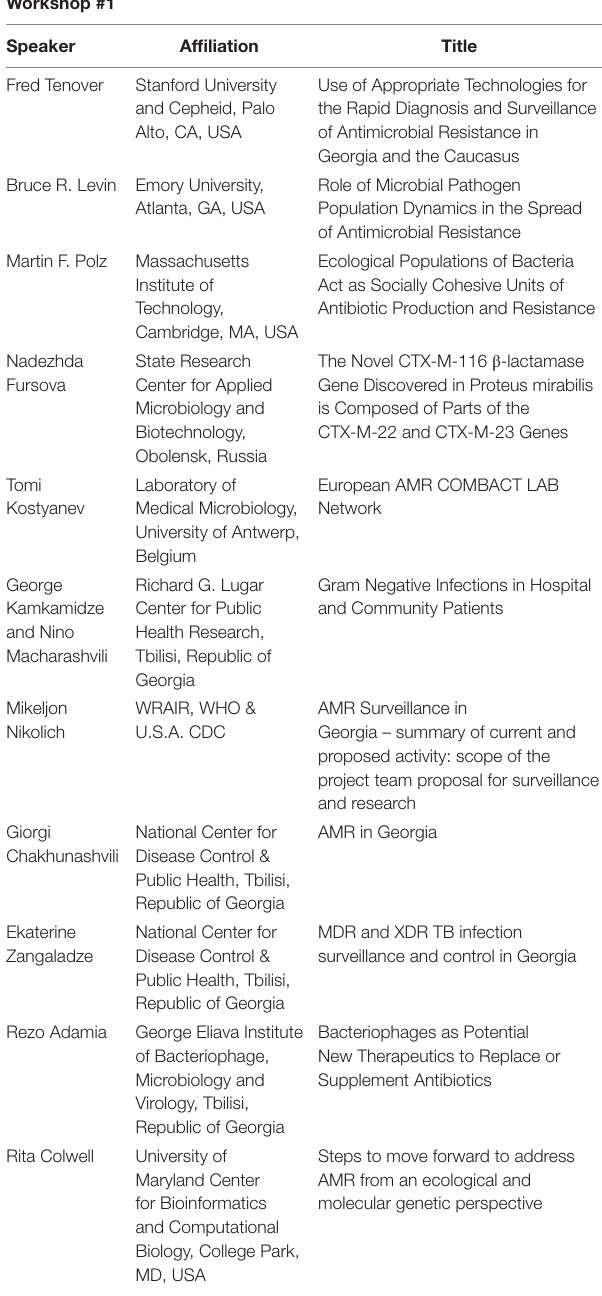
TABLe 2 | international workshop on Antimicrobial Resistance